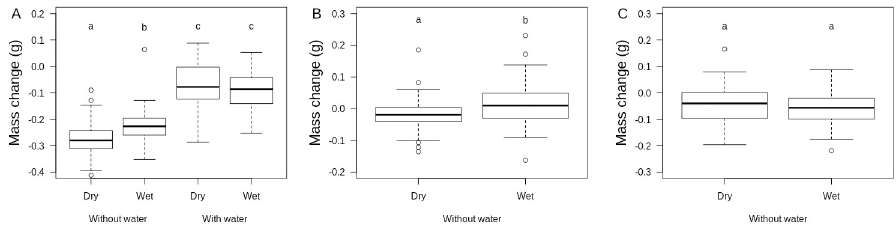
Fig 3. Boxplots of daily body mass change of yearling common lizards in three independent experiments. A. Effects of water availability (thermal gradient with or without water) and air humidity (dry: VPD = 1.87 kPa, wet: VPD = 0.46 kPa) in neutral arenas from Experiment 1. B. Effects of air humidity (wet: VPD = 0.70 kPa, super wet: VPD = 0.12 kPa) in neutral arenas from Experiment 2. Data are residual body mass change after controlling for sex differences and initial body mass. C. Effects of air humidity (same as B) in neutral arenas provided with shelters from Experiment 3. Letters indicate statistically different groups according to contrasts from the statistical models explained in the main text. Note that differences in mean mass loss between experiments are difficult to interpret because those were performed sequentially and lizards might acclimate to laboratory conditions.